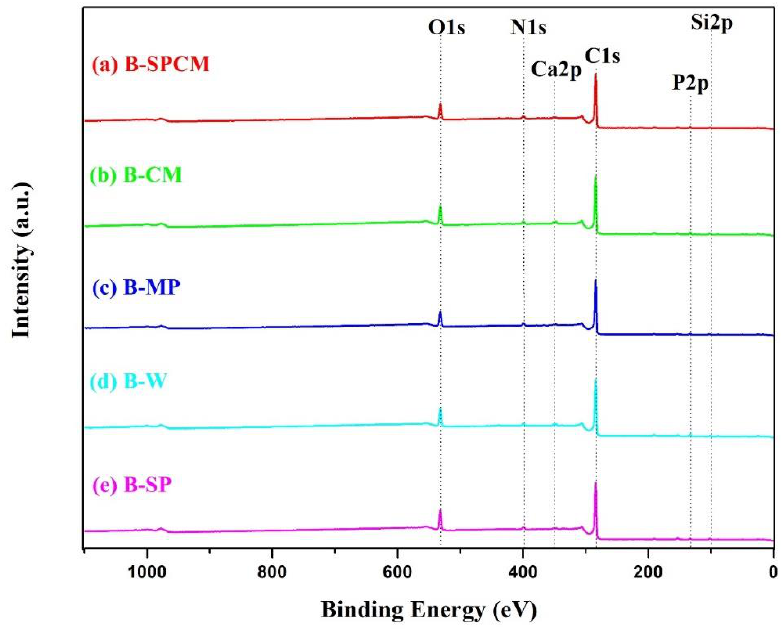
Figure 4. XPS survey spectra of ( a ) B-SPCM, ( b ) B-CM, ( c ) B-MP, ( d ) B-W, and ( e ) B-SP.